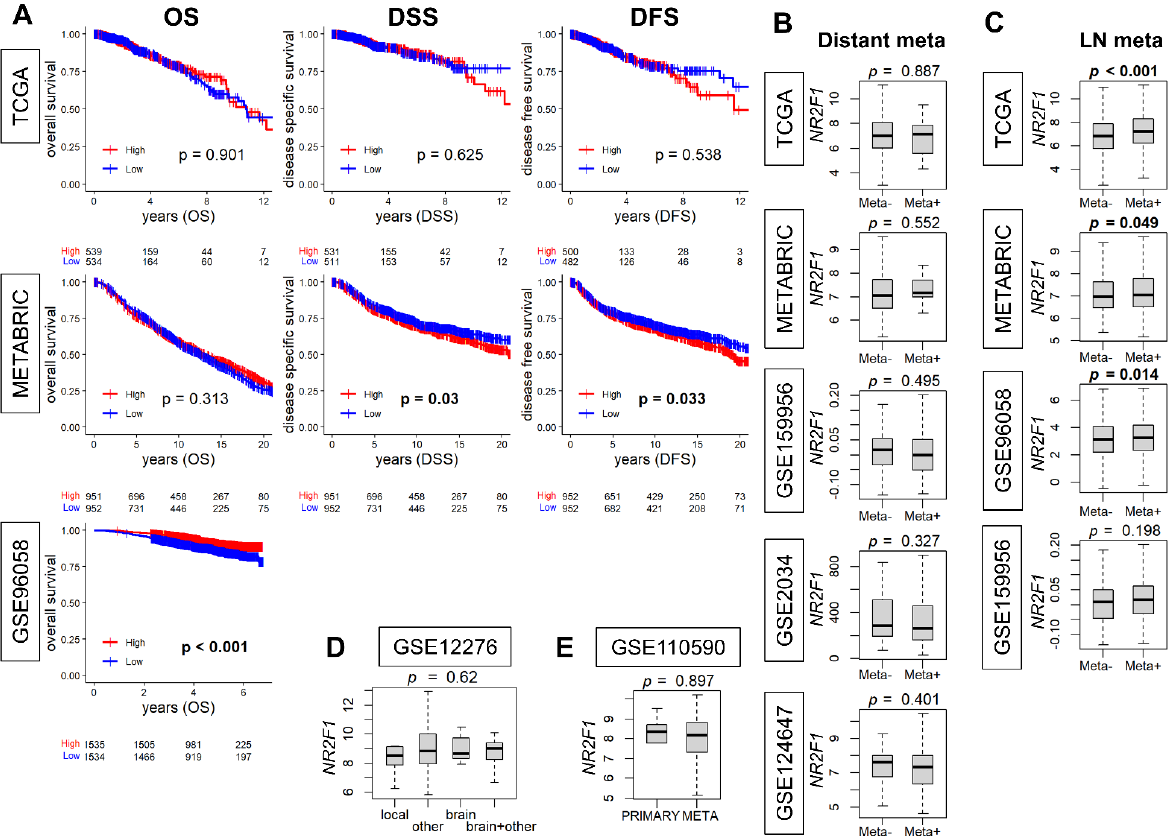
Figure 3. Association of NR2F1 with clinical parameters. ( A ) Kaplan–Meier curves of overall survival (OS), disease − specific survival (DSS), and disease − free survival (DFS) based on the high and low NR2F1 expression in three large cohorts. Log − rank test was used for the analysis, and significant p values are shown in bold. ( B ) Boxplots showing NR2F1 expression between patients with (Meta+) and without (Meta − ) distant metastasis in the five cohorts. ( C ) Boxplots showing NR2F1 expression between patients with (Meta+) and without (Meta − ) lymph node metastasis in the four cohorts. ( D ) The boxplot shows NR2F1 expression of primary breast cancer by the known site of relapse. ( E ) The boxplot shows NR2F1 expression of primary and metastatic breast cancer. Cohort names are indi- cated in the figure, and Mann–Whitney U and Kruskal–Wallis H tests were used for analysis. Sig- nificant p values are shown in bold. p < 0.05 was considered significant. 3.4. Cancer Cells That Express NR2F1 Were Not Associated with Upregulation of Metastasis- Related Gene Sets or with Downregulation of Cell Proliferation-Related Gene Sets The transcriptome of the patient cohorts was obtained from bulk tumors, which is a mixture of messenger-RNA expression signals from all cell types in the TME. Therefore, it was of interest to investigate the pathway that is involved with NR2F1 expression solely within cancer cells. We used two primary breast cancer single-cell sequencing cohorts, Cohort 1 and 2 [46,47], where 5.1% and 2.7% of cancer cells excluding the other cell types expressed any NR2F1 mRNA ( NR2F1 -positive group), respectively. GSEA showed mini- mal concordance between the two cohorts in the NR2F1 -positive group (Figure 4). In